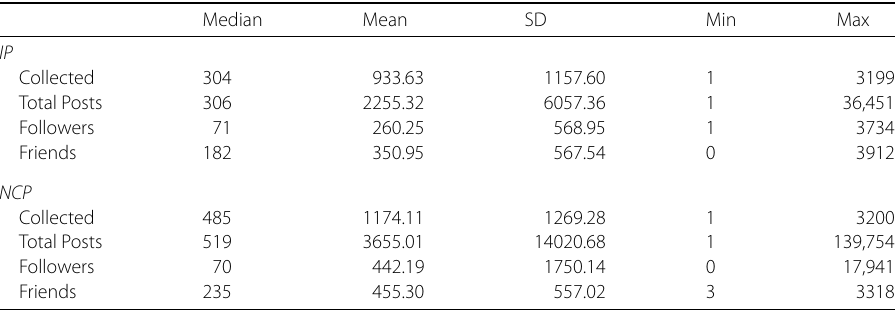
Table 2 Data from Survey Respondents’ Twitter